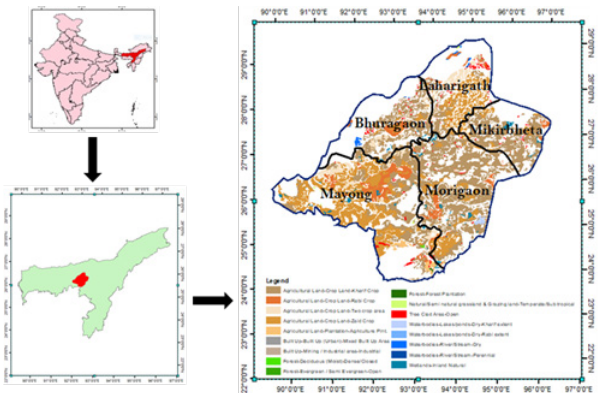
Figure 1. Base Map of Morigaon Distrct, Assam showing Agriculture